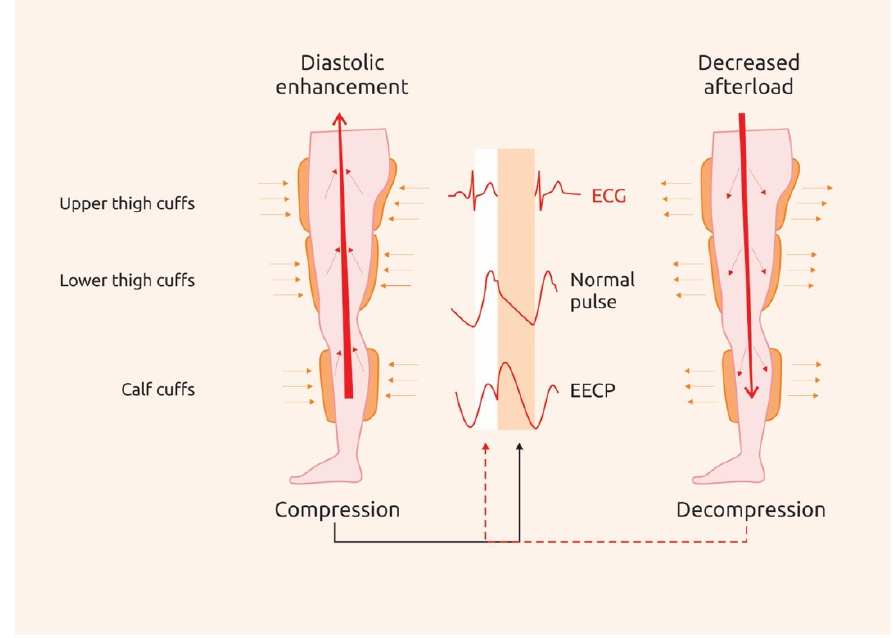
Figure 2. Principles of enhanced external counterpulsation (EECP). EECP produces a diastolic Figure2.